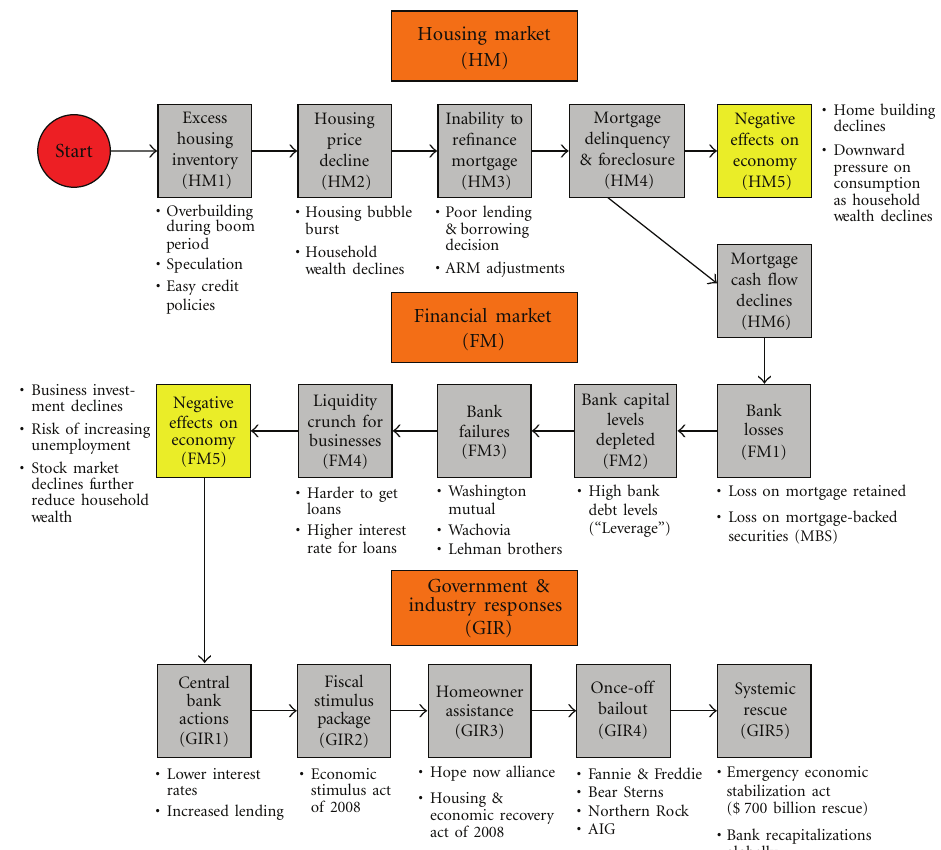
Figure 6: Diagrammatic overview of the subprime mortgage crisis (cid:2) compare (cid:5) 51 (cid:6)(cid:3)